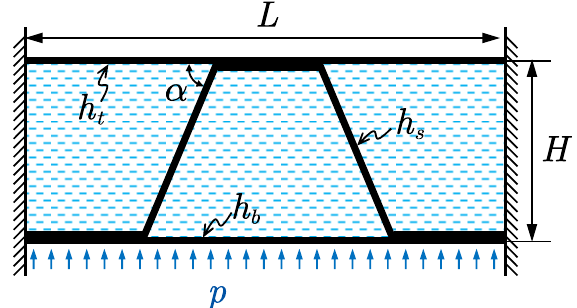
Figure 10. A vibro-acoustic model of a unit cell of the sandwich plate with corrugated core.